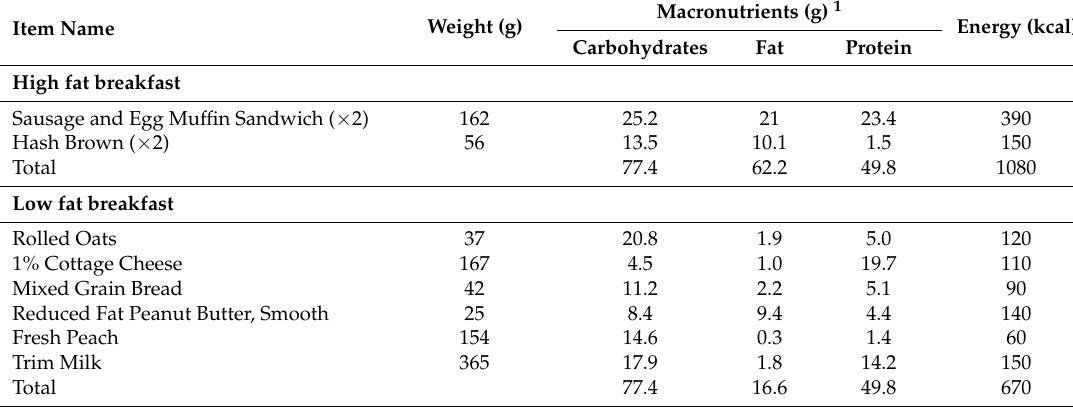
Table 1. Macronutrient composition of high- and low-fat